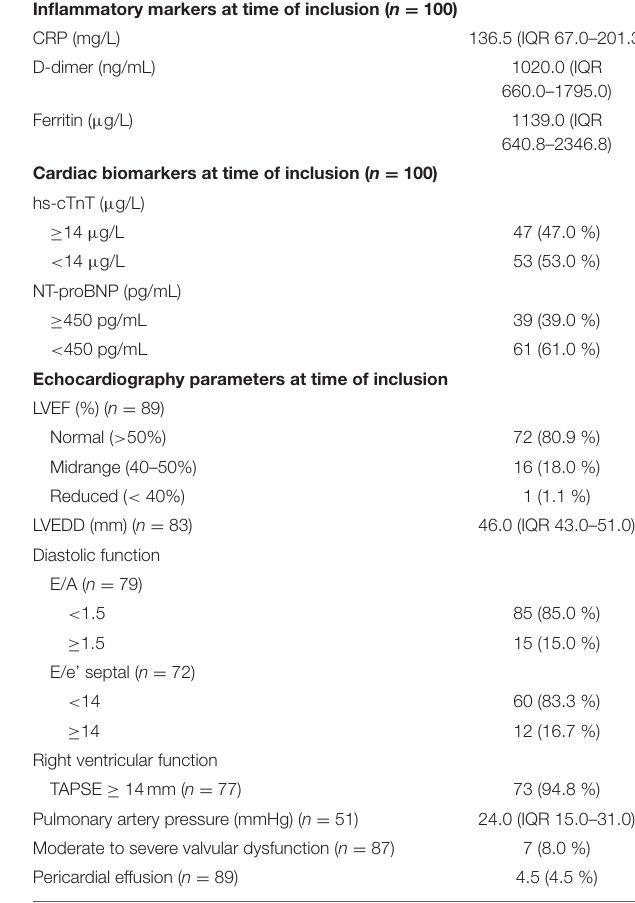
TABLE 1 | Baseline demographics, disease severity, laboratory assessments, and echocardiographic parameters of patients on admission to the intensive care